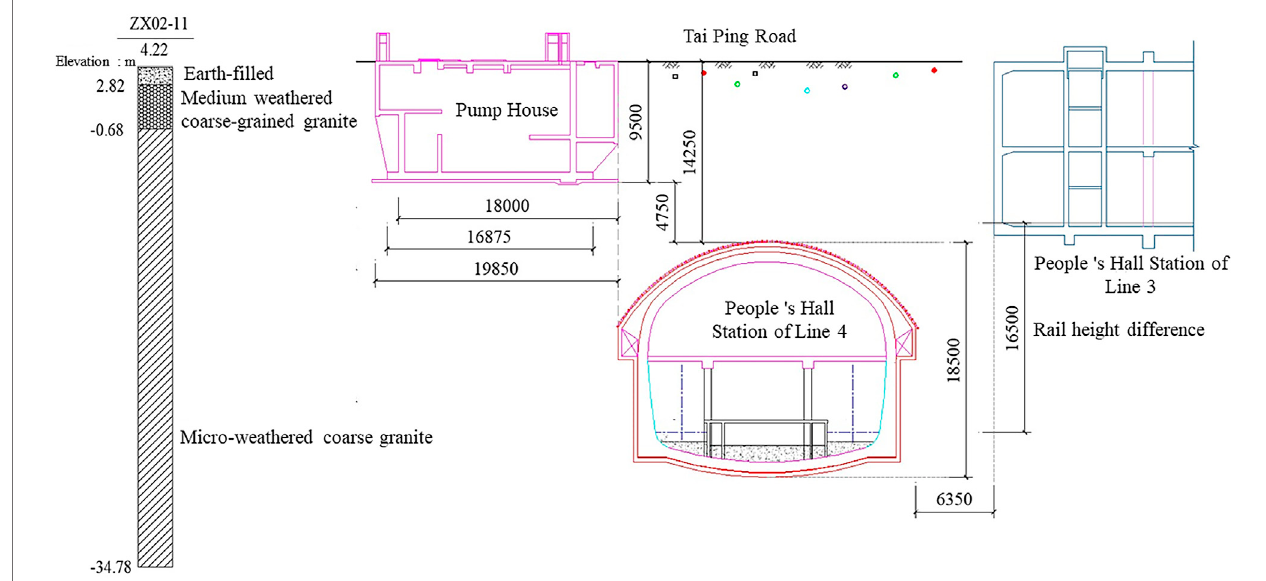
FIGURE 1 | Relative location of the Line 4 People ’ s Hall Station and adjacent structures (unit: mm).